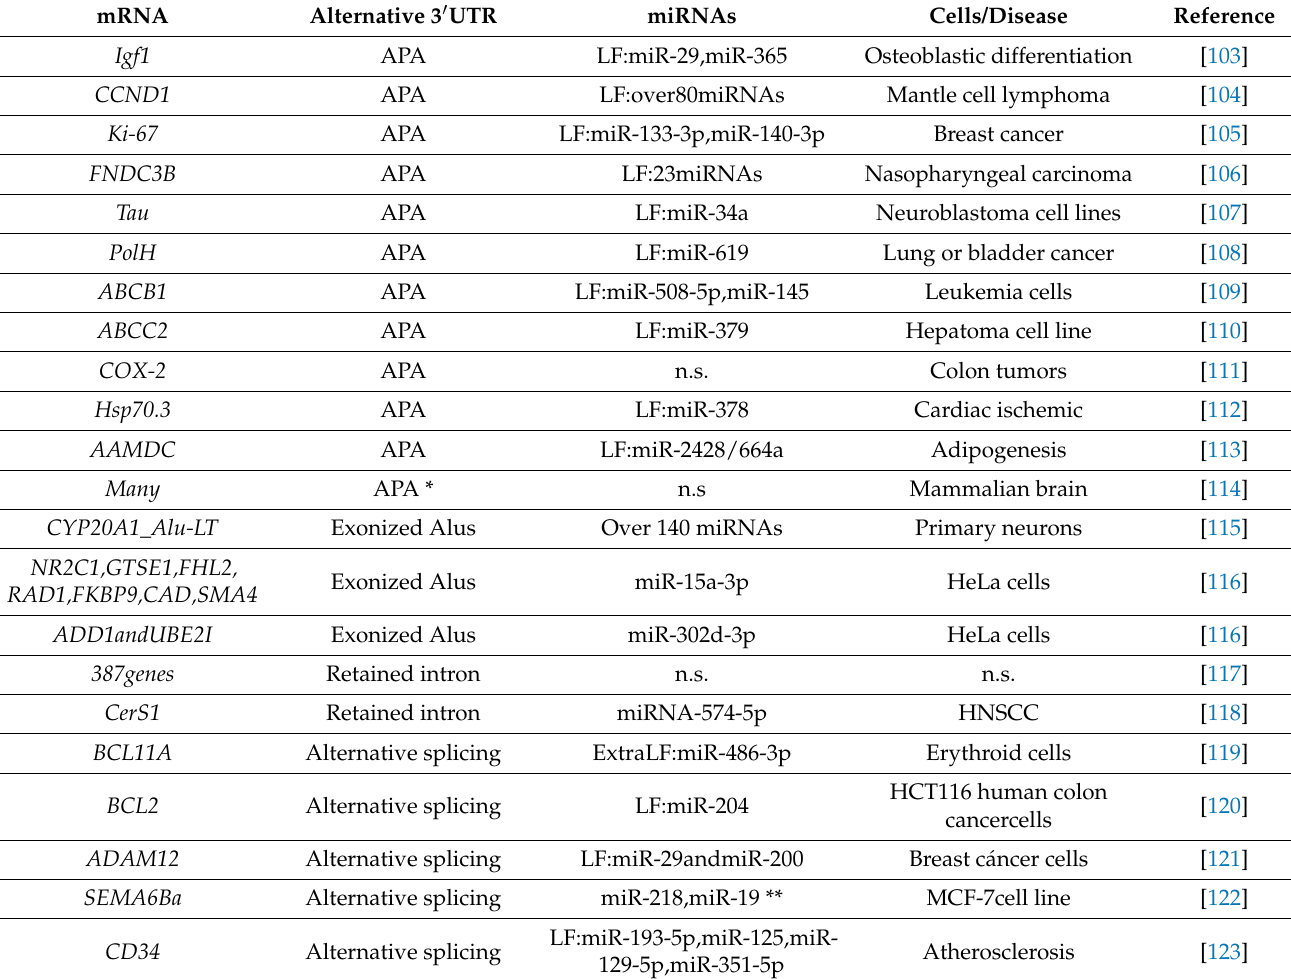
Table 1. Mechanisms that generate alternative 3 (cid:48) UTR isoforms and their impact on miRNA binding. Shown are the transcript affected, the mechanism of 3 (cid:48) UTR shortening, the miRNA binding sites lost in the isoform affected, the cells/disease in which the 3 (cid:48) UTR were detected and the reference of the work. See text for more details.